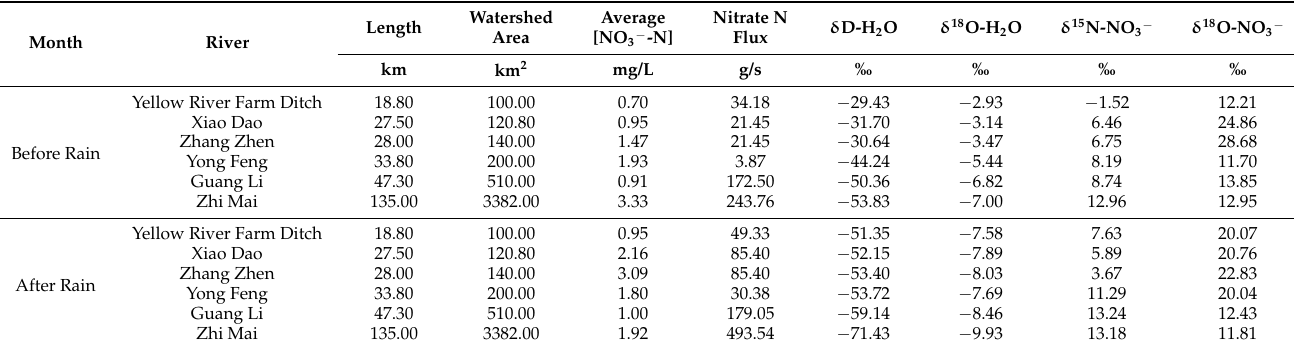
Table 2. Basic characteristics of the rivers in the study